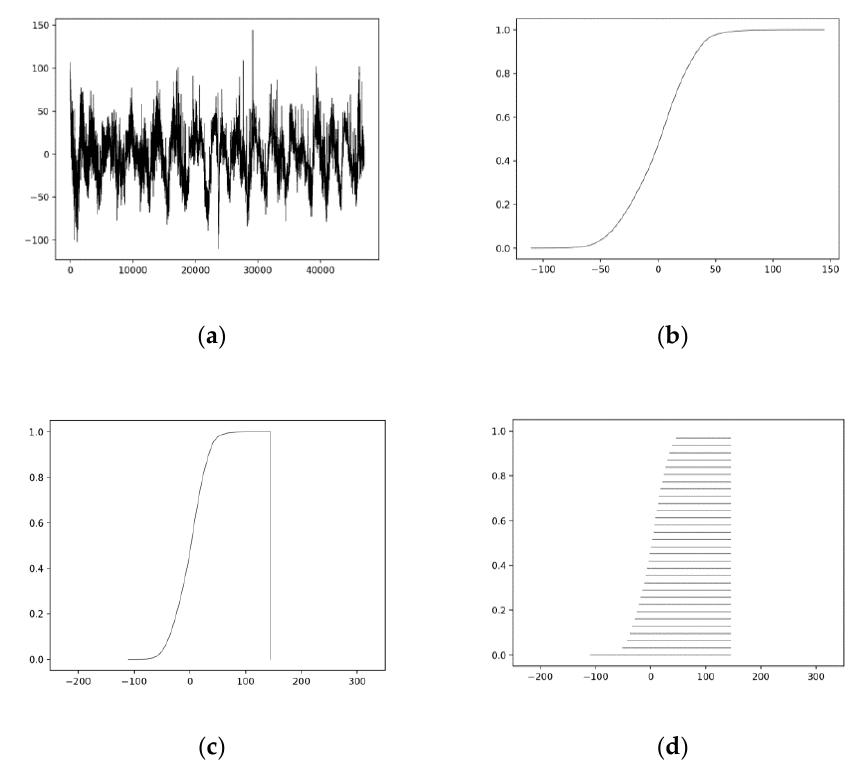
Figure 1. Induction of IN F from an electroencephalography (EEG) signal: ( a ) An EEG signal. ( b ) The corresponding distribution function. ( c ) The membership-function-representation of the induced IN F matches its distribution function. ( d ) The interval-representation of IN F is shown for L = 32 intervals.